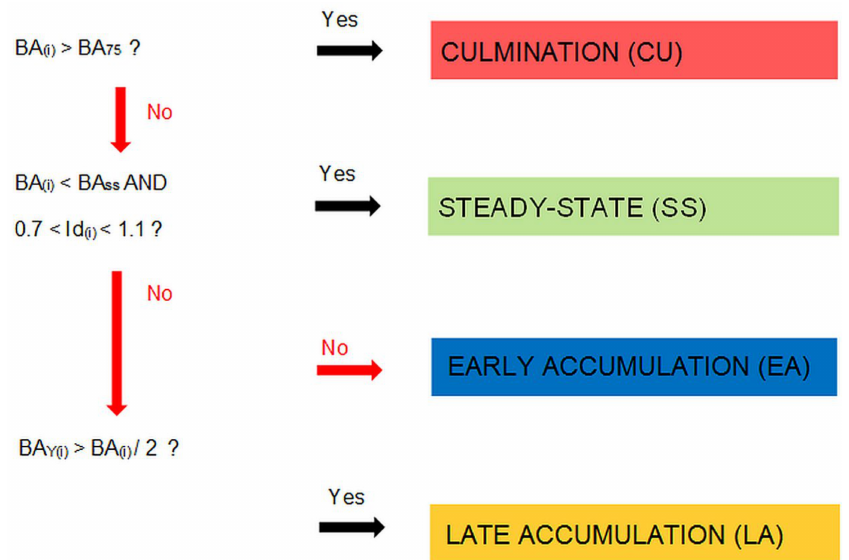
Figure 1. Scheme of the patch classification used in this study. BA (i) —local basal area in the i th stand patch, BA 75 —75th percentile of the local basal area as estimated by sampling, BAss —threshold maximal basal area for the steady-state phase, I d(i) —index of diameters at breast height (dbh) differ- entiation in the i th stand patch, BA Y(i) —total basal area of all the trees within the i th stand patch with a dbh lower than the median basal area tree diameter (dbh BA